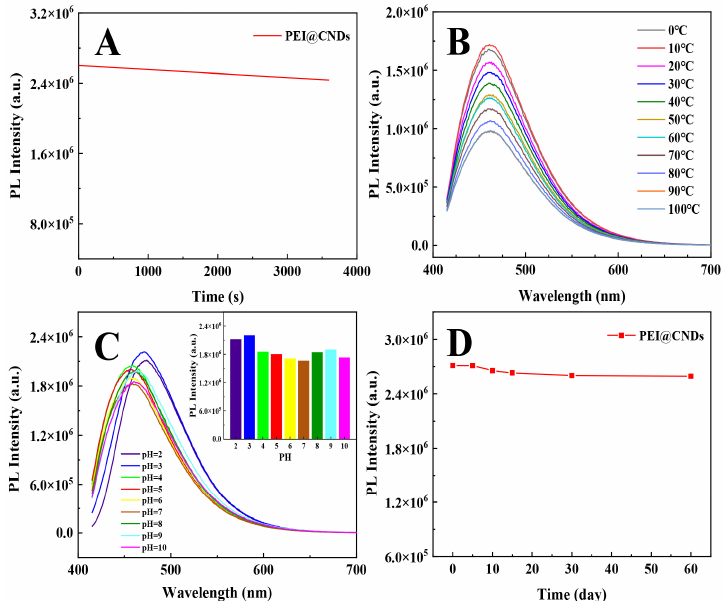
Figure 6. The photo-stability of the PEI@CNDs. ( A ) The photo-bleaching resistance; ( B ) the PL peak intensities change with temperature; ( C ) the PL spectra varying with pH, the inset shows the corresponding bar chart; and ( D ) the PL peak intensity changes within 60 days.